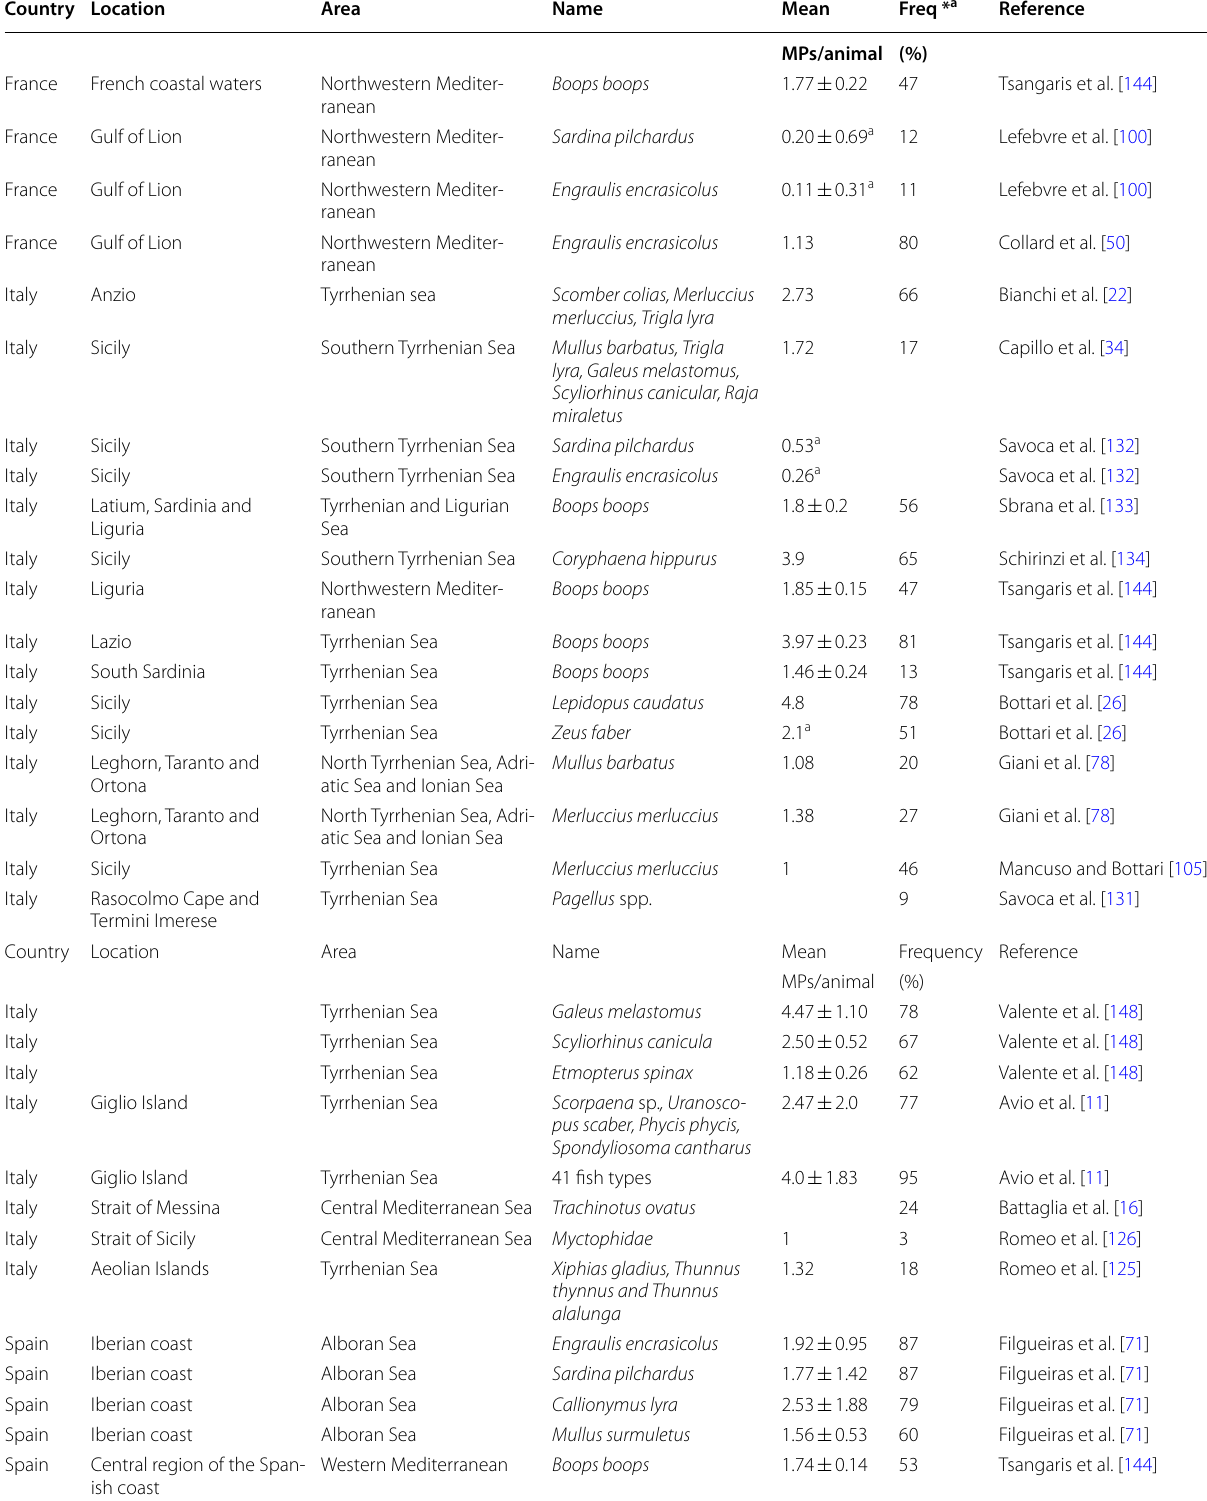
Table 8 A summary of the number of MP items found in fish around the western Mediterranean basin Country